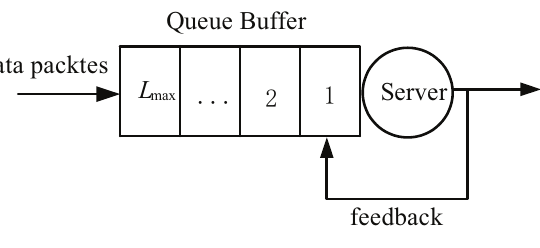
Figure 2. Feedback queuing